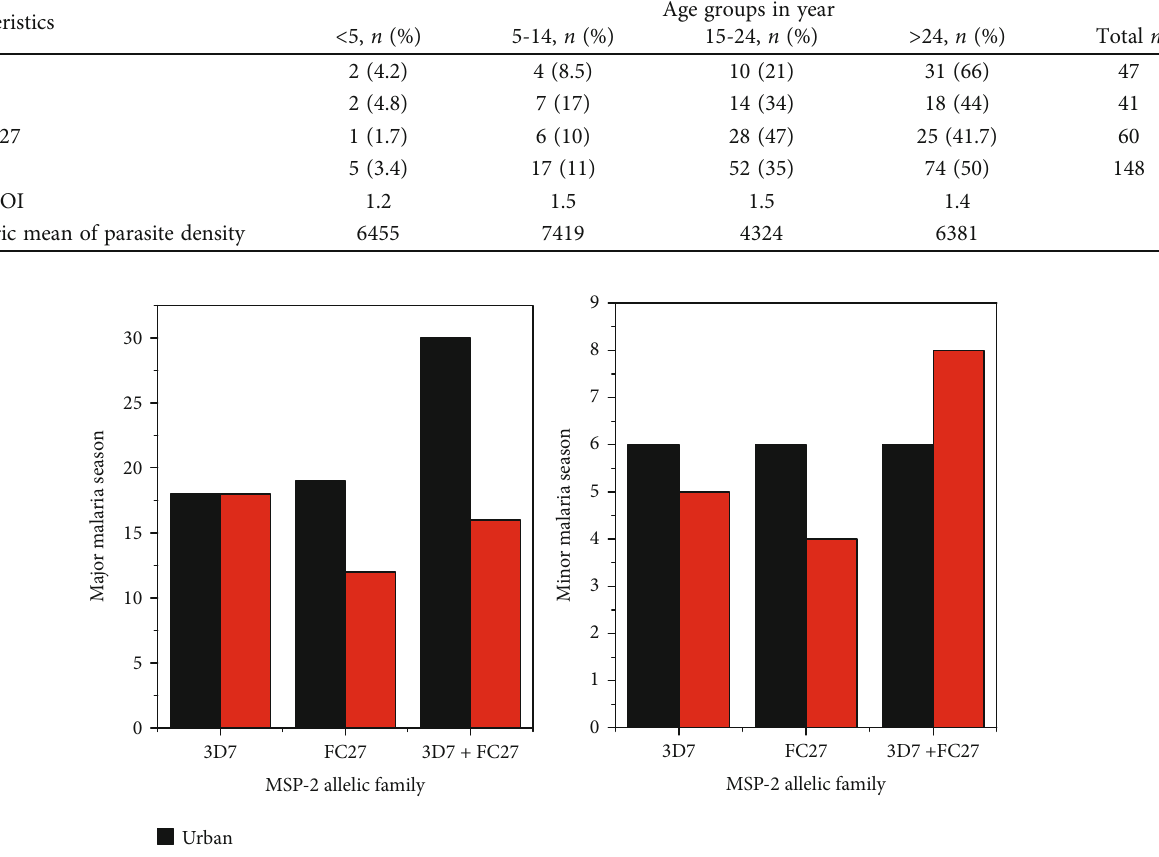
Table 4: Distribution of msp-2 allelic variants, mean MOI, and geometric mean of parasite density among di ff erent age groups of malaria patients due to P. falciparum in Adama and its surroundings ( n = 148 ). Characteristics